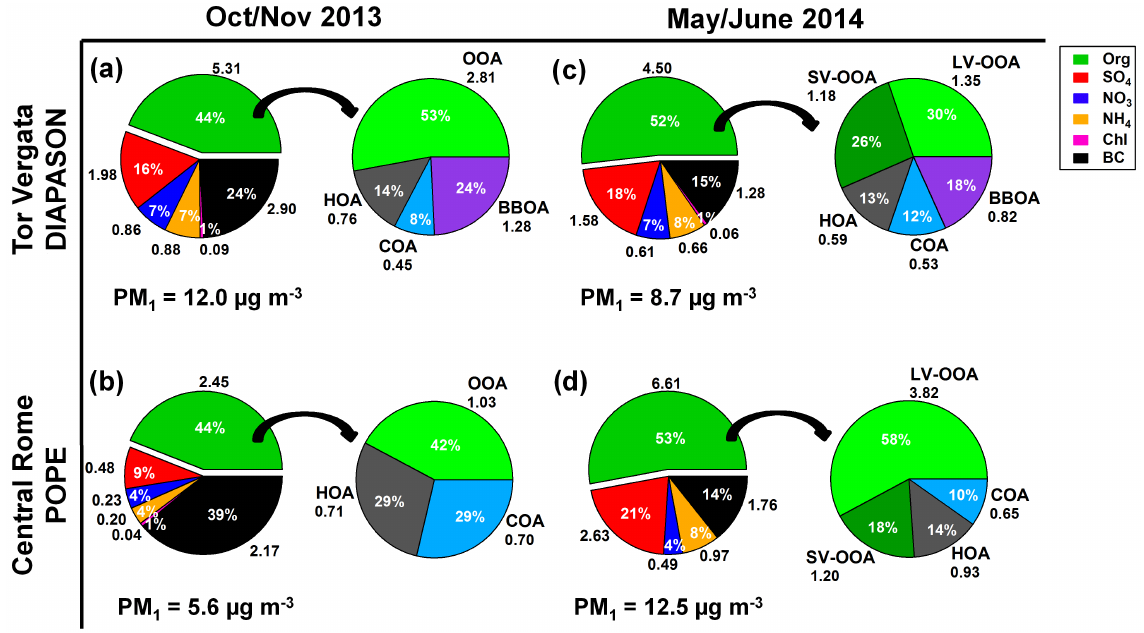
Figure 2. Mean chemical composition (µgm − 3 ) of non-refractory PM 1 together with BC (left chart in panels a – d ) and PMF-separated organic fraction (right chart in panels a – d ) for each measurement period. PM 1 values below the pie charts represent total mass concentration of AMS-measured species plus BC. The organic fraction measured in central Rome was corrected for contributions from cigarette smoke in the local environment (Sect. 4.2.5, it was also omitted from the pie charts depicting the PMF-separated organic fraction).